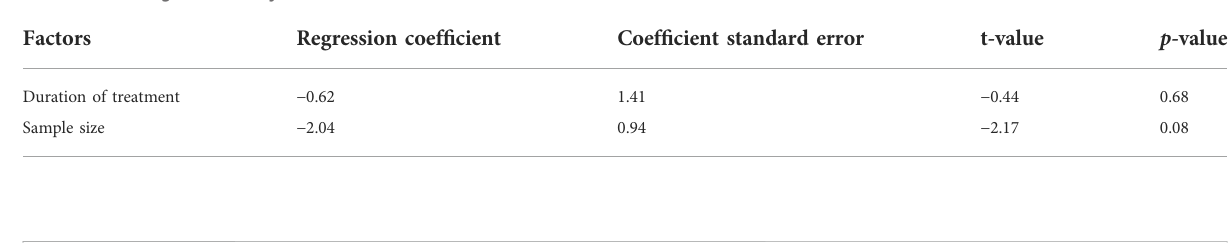
FIGURE 6 Forest plot for carotid plaque area.